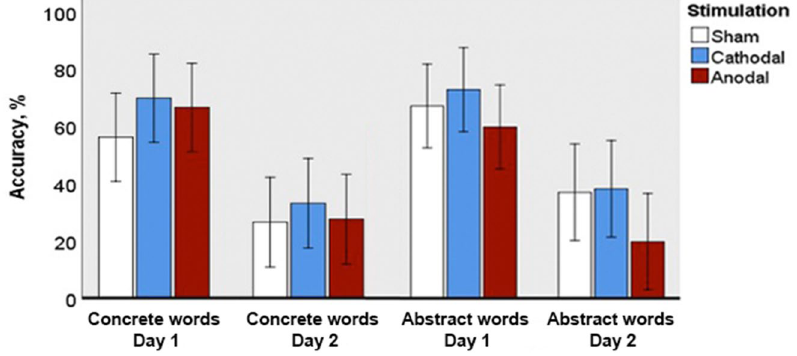
Figure 2. Accuracy in the free recall task for novel concrete and abstract words immediately after learning (Day 1) and following an overnight sleep (Day 2). Error bars denote 95% confidence intervals.